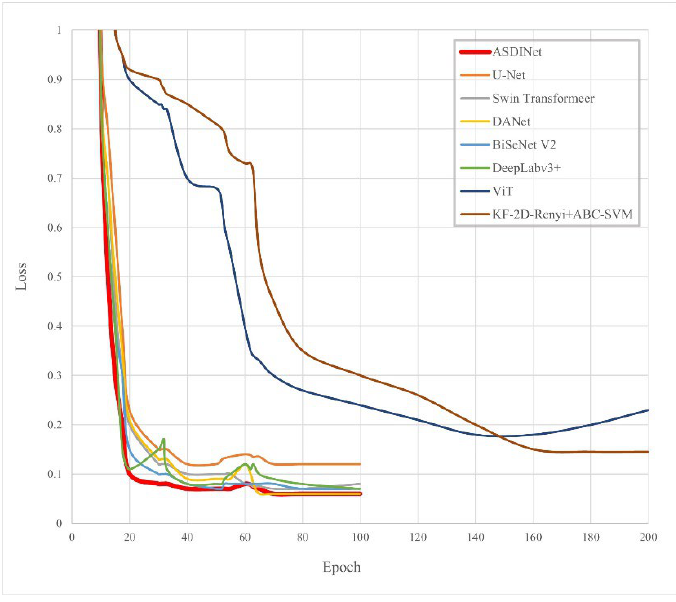
Figure 8. The losses of each model.